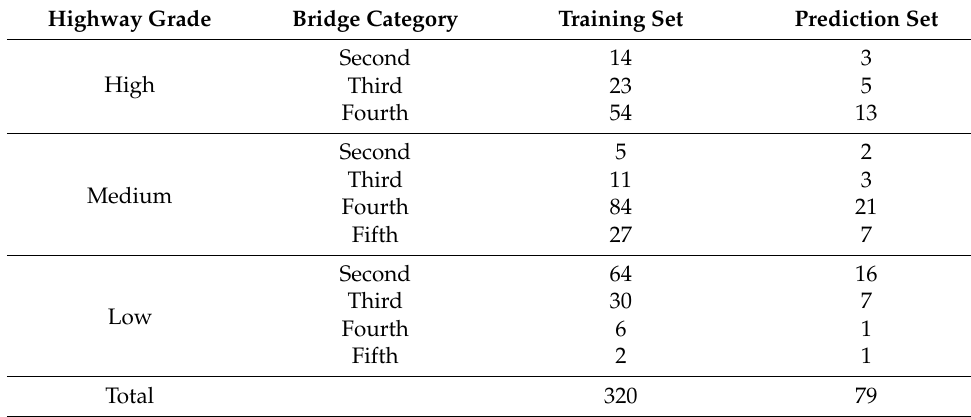
Table 4. Classification of the database.